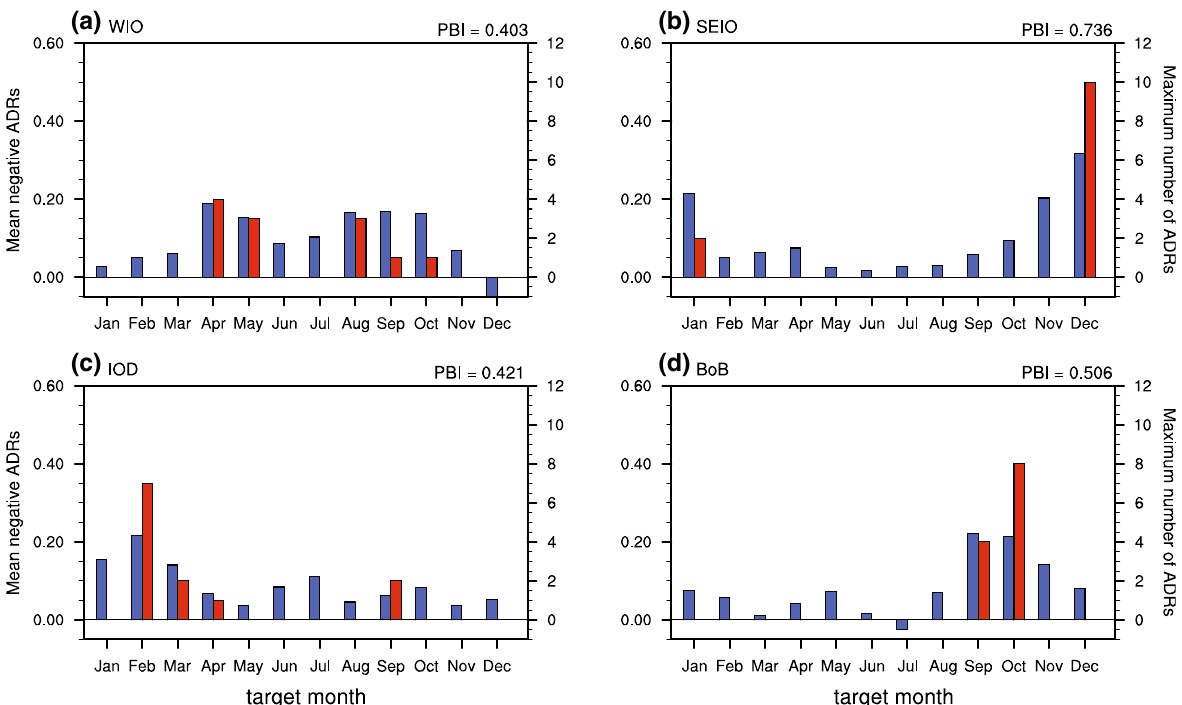
Fig. 4 Mean ADRs for all 12 lead months (left y axis) and the frequency of the maximum ADRs (right y axis) as a function of the target calendar month (x axis) for the a western tropical Indian Ocean (WIO), b southeastern tropical Indian Ocean (SEIO), c tropical Indian Ocean dipole (IOD), and d Bay of Bengal (BoB). Blue bar is the mean ADRs for all 12 lead months (left y axis), and red bar is the frequency of the maximum ADRs (right y